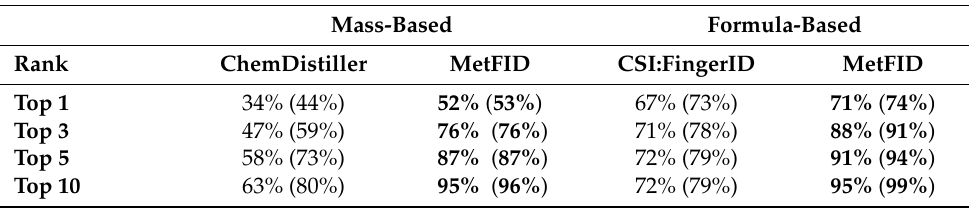
Table 3. Performance comparison of ChemDistiller and CSI:FingerID with MetFID using the CASMI 2016 dataset as a testing dataset. The percentage that is outside the parenthesis includes the unan- notated peak lists in the ranked result, which means 208 spectra in total. The percentages inside parenthesis are calculated by excluding the peak lists whose candidate lists do not include the true compounds, in order to account for the situation when the target compound cannot be found by searching against compound databases. The result of the best performing tool under each category is shown in